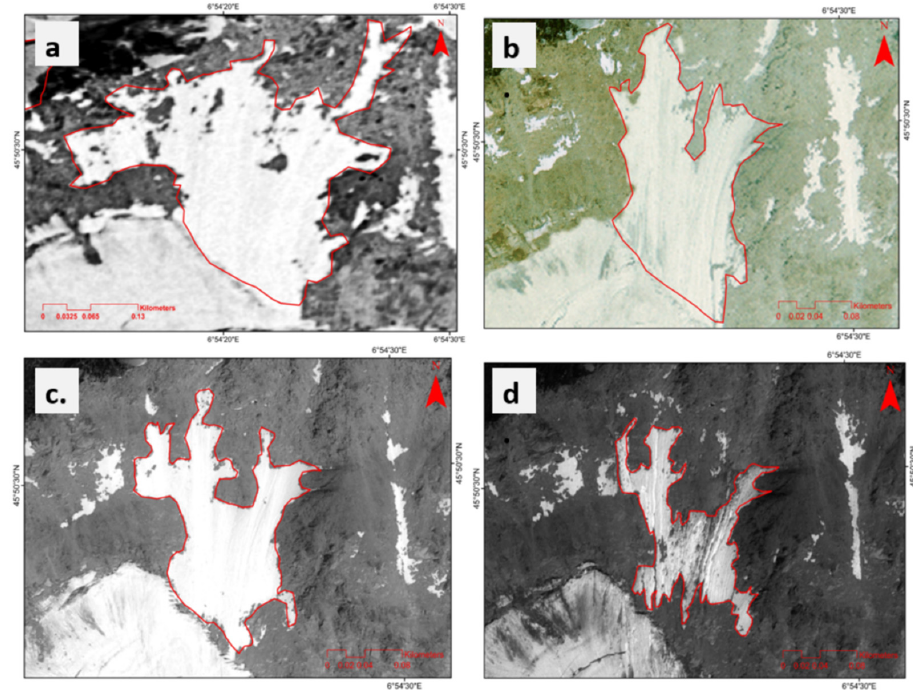
Figure 4. IA on the south face of the Brenva glacier on the Italian side of the massif. ( a ) IGN